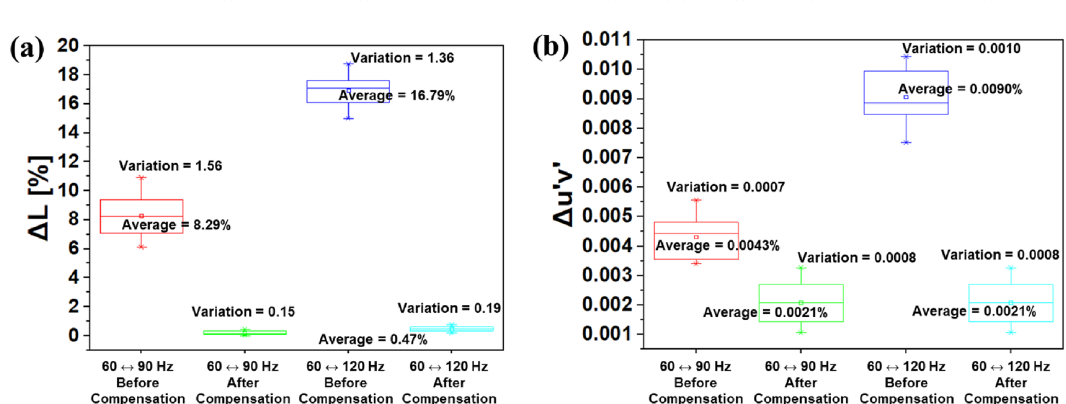
Figure 7. ( a ) The luminance and ( b ) color differences under frequency changes. The initial voltages were: − 2.8 V for 60 Hz, − 2.6 V for 90 Hz, and − 2.4 V for 120 Hz. The displayed gamma scales for ( c ) 60 Hz and ( d ) 120 Hz, after V INI compensation was applied.